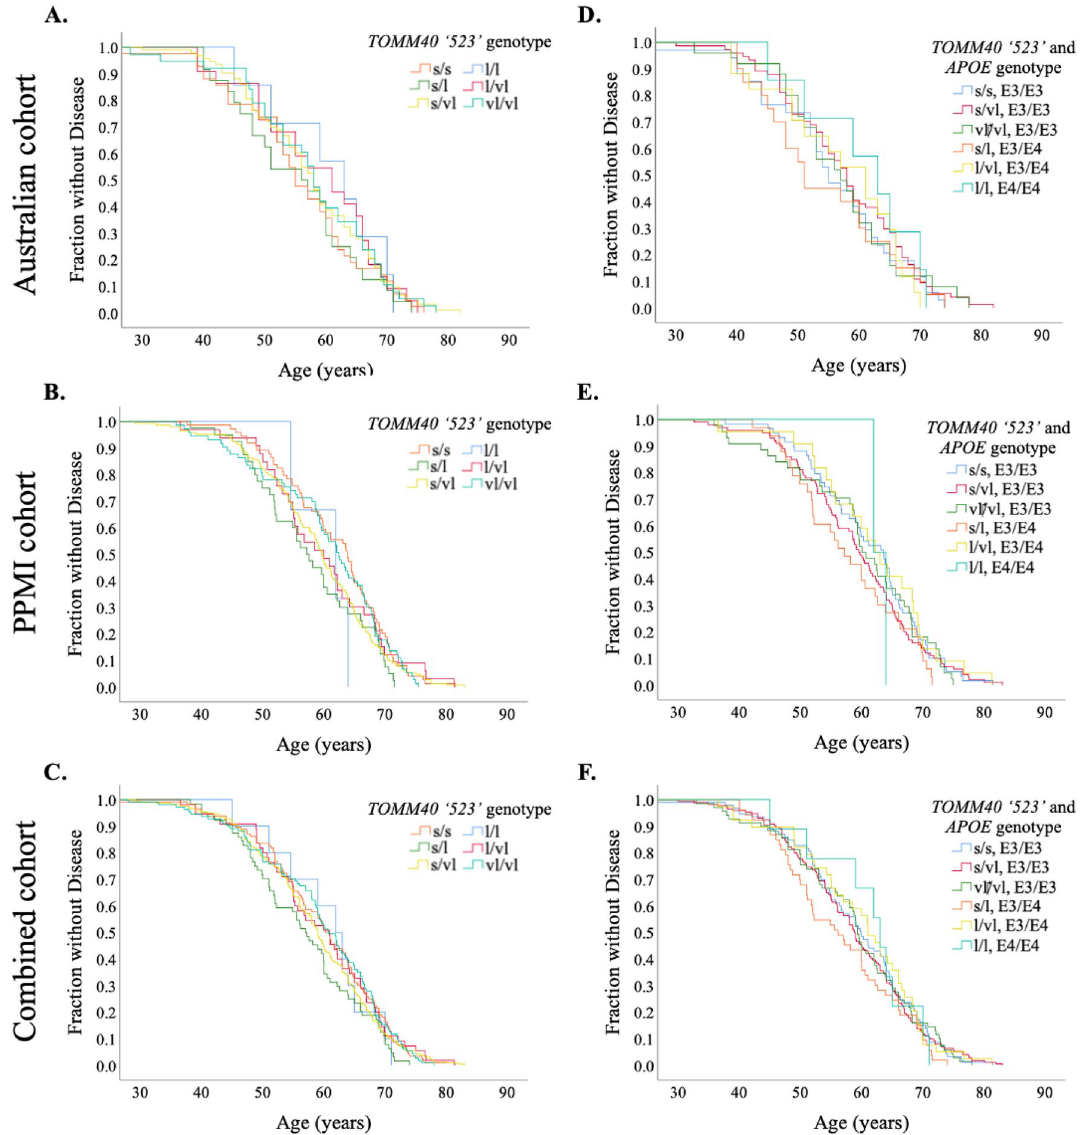
Figure 1. Age of onset of PD symptom curves for TOMM40 ‘523’ genotypes. ( A – C ) indicate the age at which symptoms of PD began when stratified by TOMM40 ‘523’ genotype, as demonstrated by Kaplan–Meier curves. ( C – E ) indicate the age at which symptoms of PD began when stratified by TOMM40 ‘523’ and APOE genotype, as demonstrated by Kaplan–Meier curves. PPMI, Parkinson’s Progression Markers Initiative; S/S, short/short; S/L, short/long; S/VL, short/very long; L/L, long/long; L/VL, long/very long; VL/VL, very long/very long; S, short; L, long; VL, very long; ε2/ε2, Apolipoprotein epsilon 2/epsilon 2; ε2/ε3, Apolipoprotein epsilon 2/epsilon 3; ε2/ε4, Apolipoprotein epsilon 2/epsilon 4; ε3/ε3, Apolipoprotein epsilon 3/epsilon 3; ε3/ε4, Apolipoprotein epsilon 3/epsilon 4; ε4/ε4, Apolipoprotein epsilon 4/epsilon